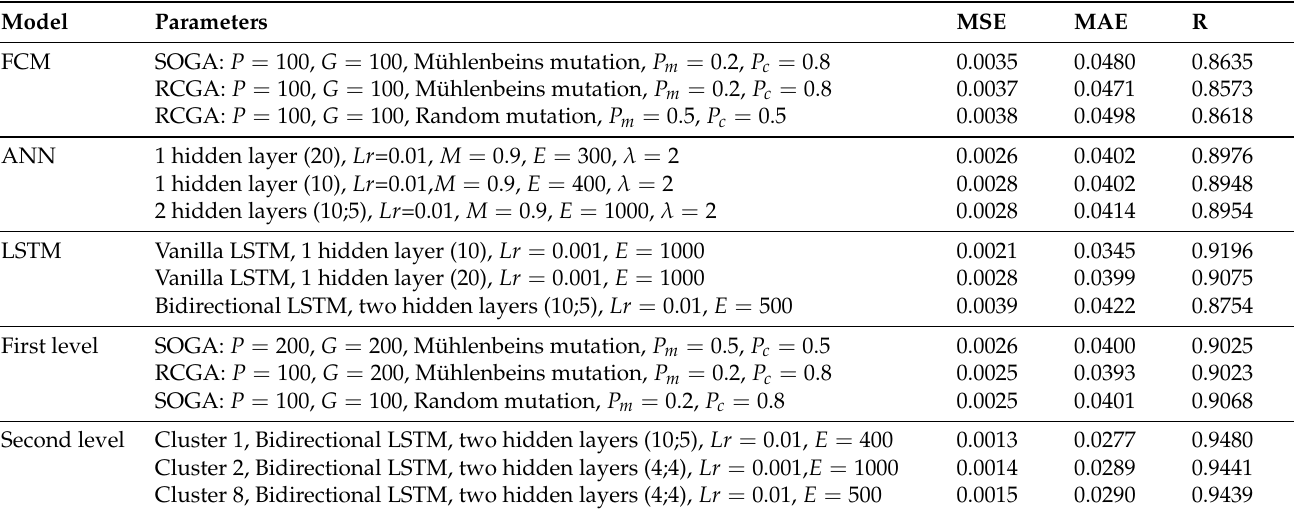
Table 3. Results of comparative analysis.